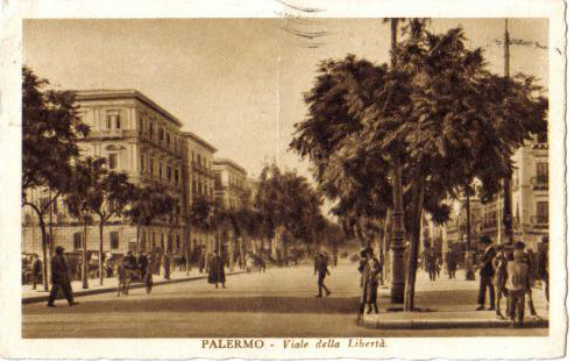
Figure 1 . Via della Libertà, historical archive,